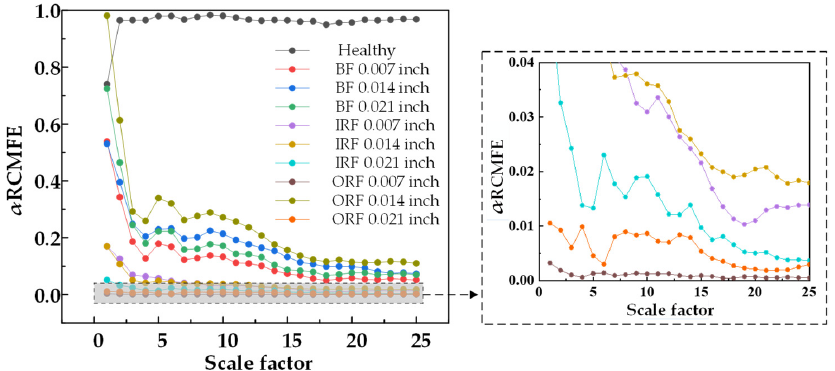
Figure 7. α RCMSE entropy values of 25 scale factors under different damage degrees.